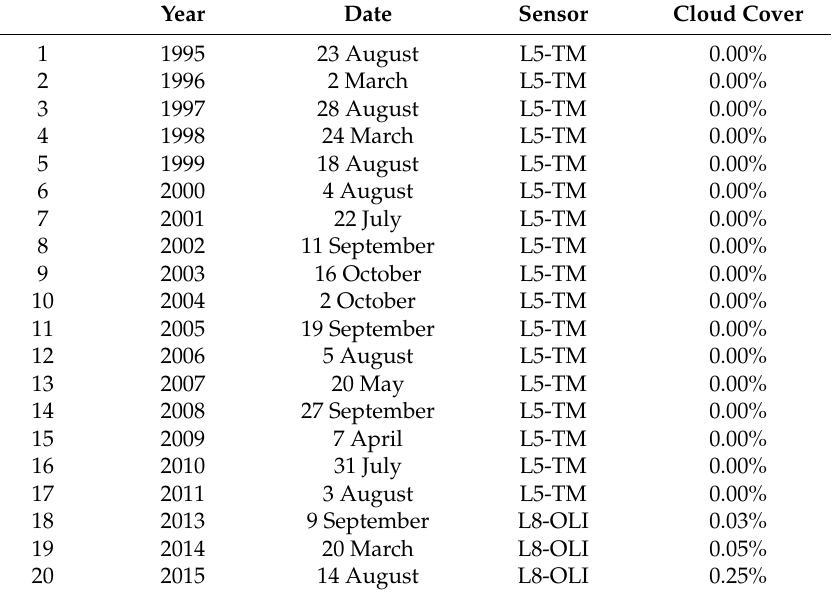
Table 1. Landsat acquisition date and sensor